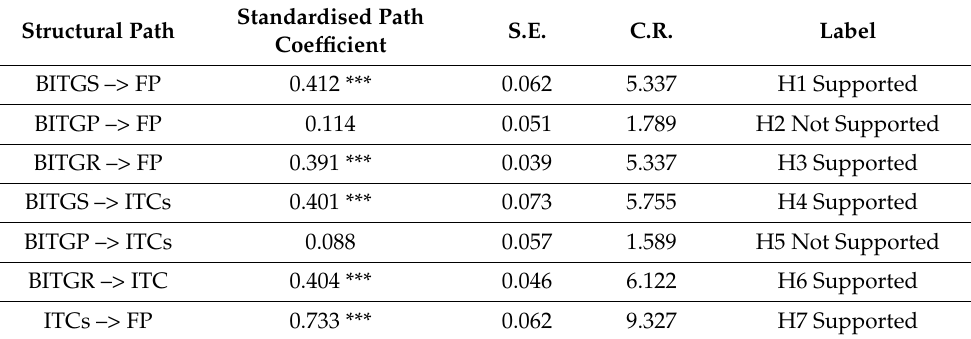
Table 4. Results of the first three causal steps of the Baron and Kenny method. Structural Path Standardised Path Coefficient